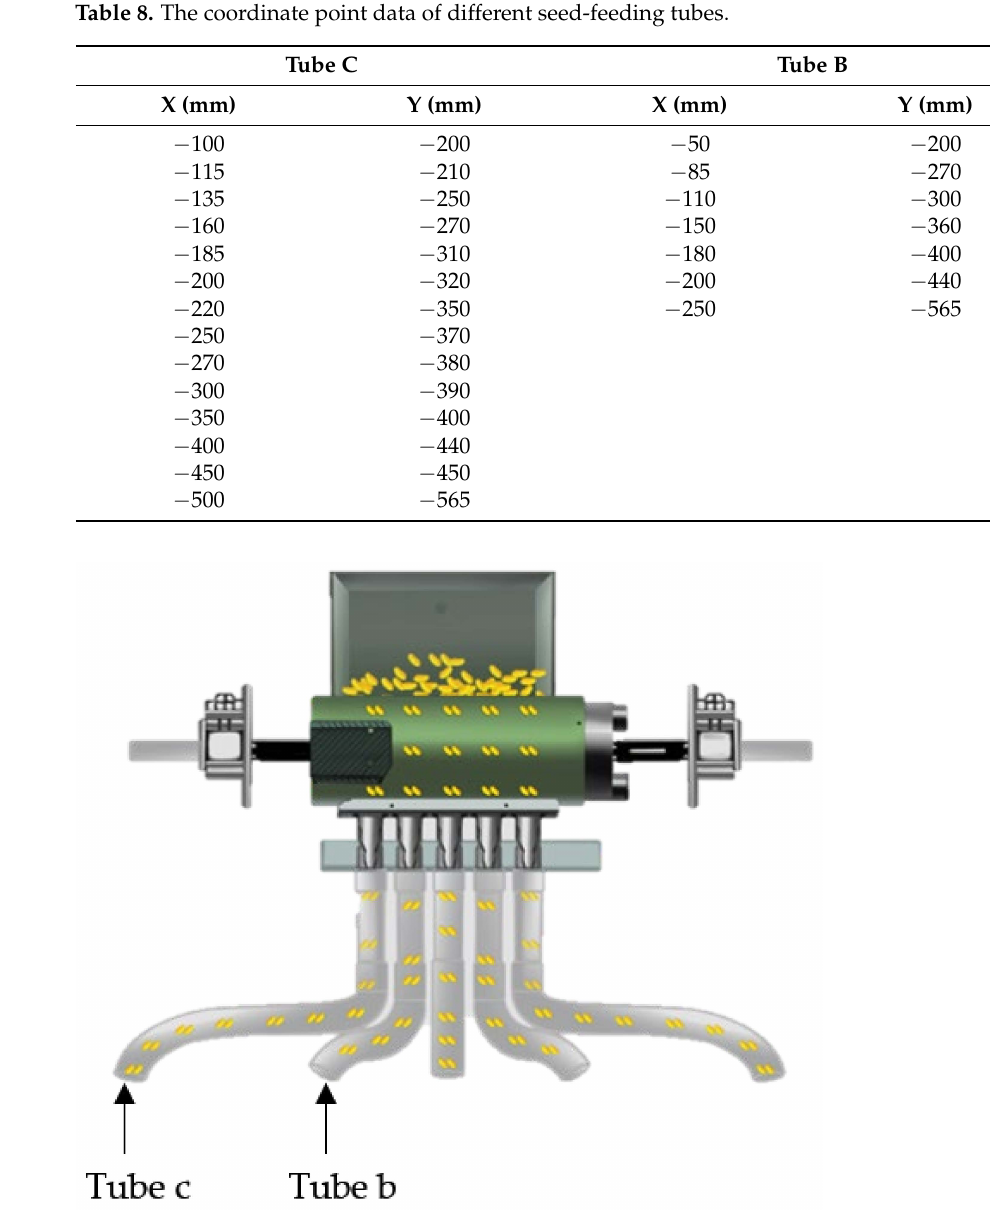
Figure 15. The schematic diagram of distributed seed-feeding